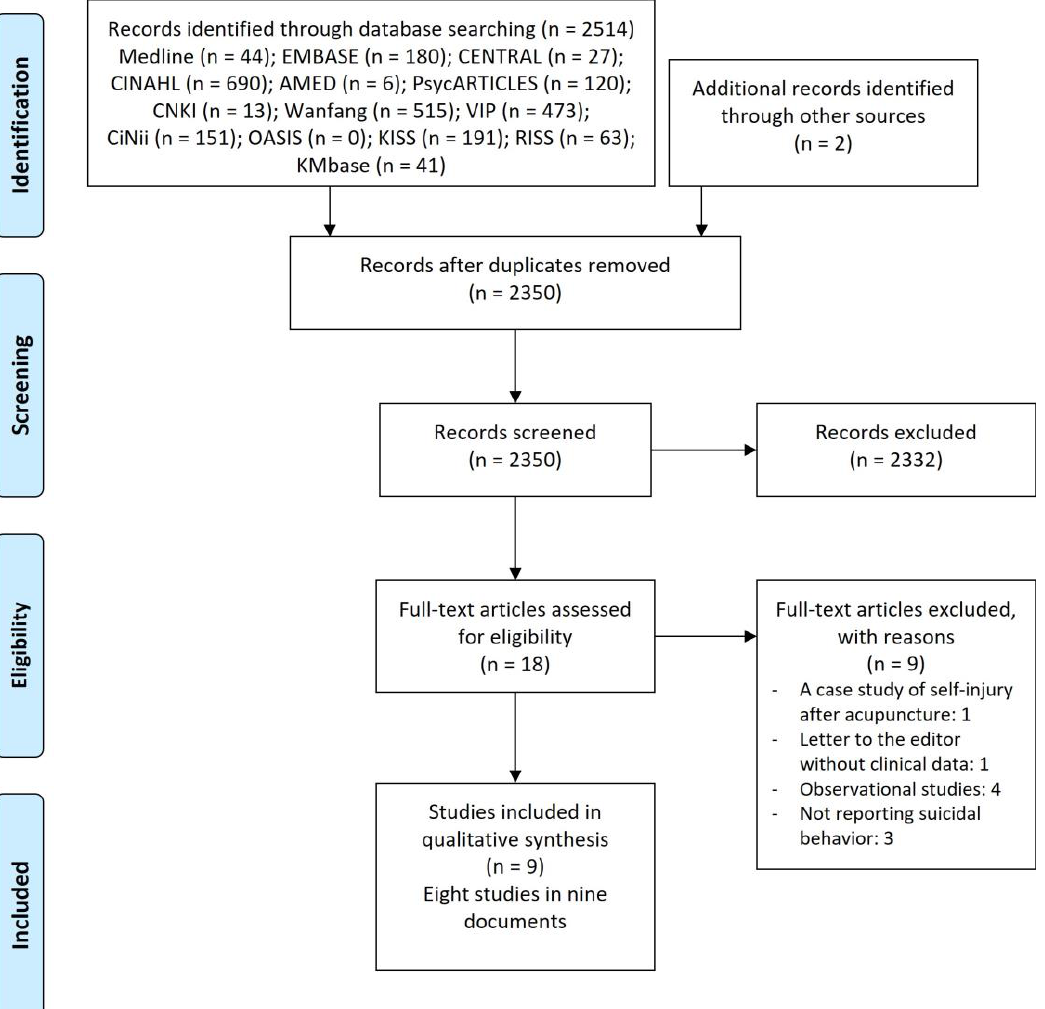
Figure 1. A PRISMA flow diagram of the literature screening and selection processes. Abbreviations. AMED, Allied and Complementary Medicine Database; CENTRAL, Cochrane Central Register of Controlled Trials; CINAHL, Cumulative Index to Nursing and Allied Health Literature; CNKI, China National Knowledge Infrastructure; KISS, Korean Studies Information Service System; OASIS, Oriental Medicine Advanced Searching Integrated System; RISS, Research Information Service System.